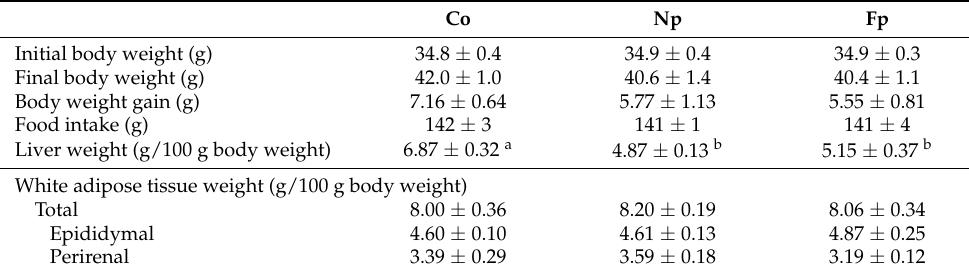
Table 1. Effect of experimental diet on growth parameters in db / db mice.